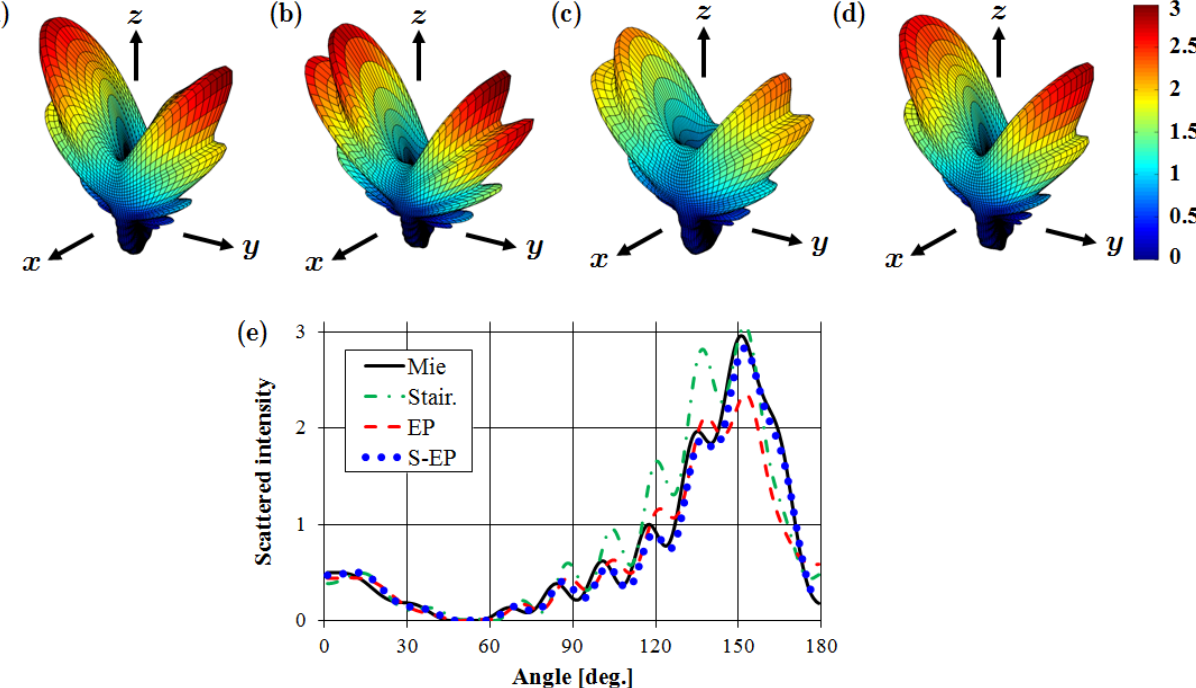
Figure 7. Calculated E scattered intensity distributions for a Au sphere on surface S of y radius 1 : 2 a using: ( a ) Mie theory; ( b ) Staircase model; ( c ) EP model; ( d ) S-EP model; ( e ) Angular intensity distributions on contour C in the y - z